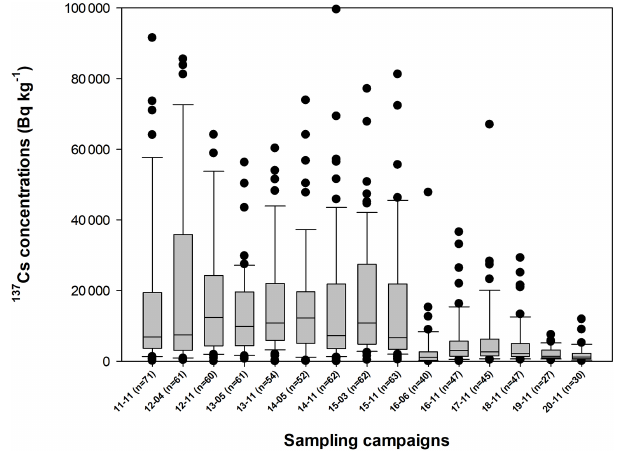
Figure 2. Evolution of 137 Cs concentrations in river sediment sam- ples collected in the river catchments draining the main radioac- tive plume near the FDNPP between November 2011 and Novem- ber 2020 (all activities were decay-corrected to the sampling